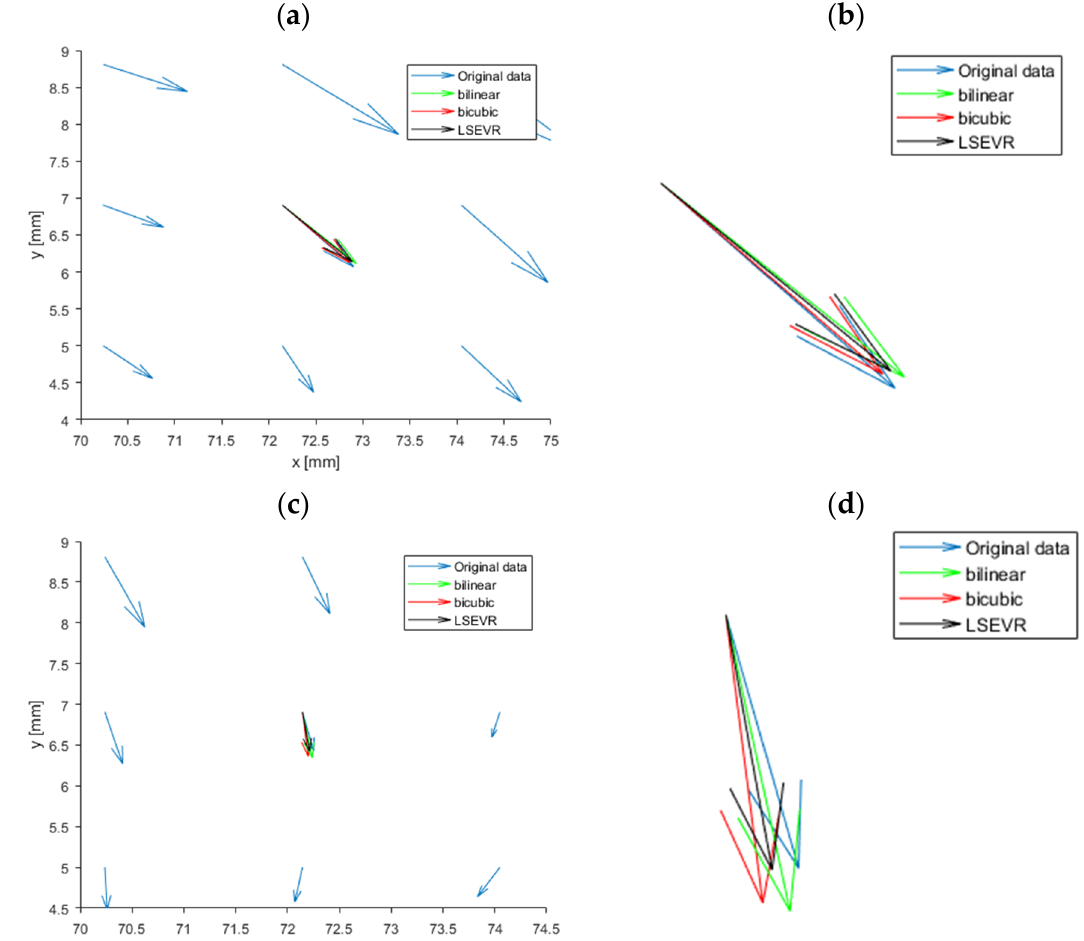
Figure 9. Comparison of performance of vector replacement methods; bilinear, bicubic and LSEVR for two example times. ( a ) t = 2503, ( c ) t = 2782. ( b , d ) are zoomed views of each respectively.